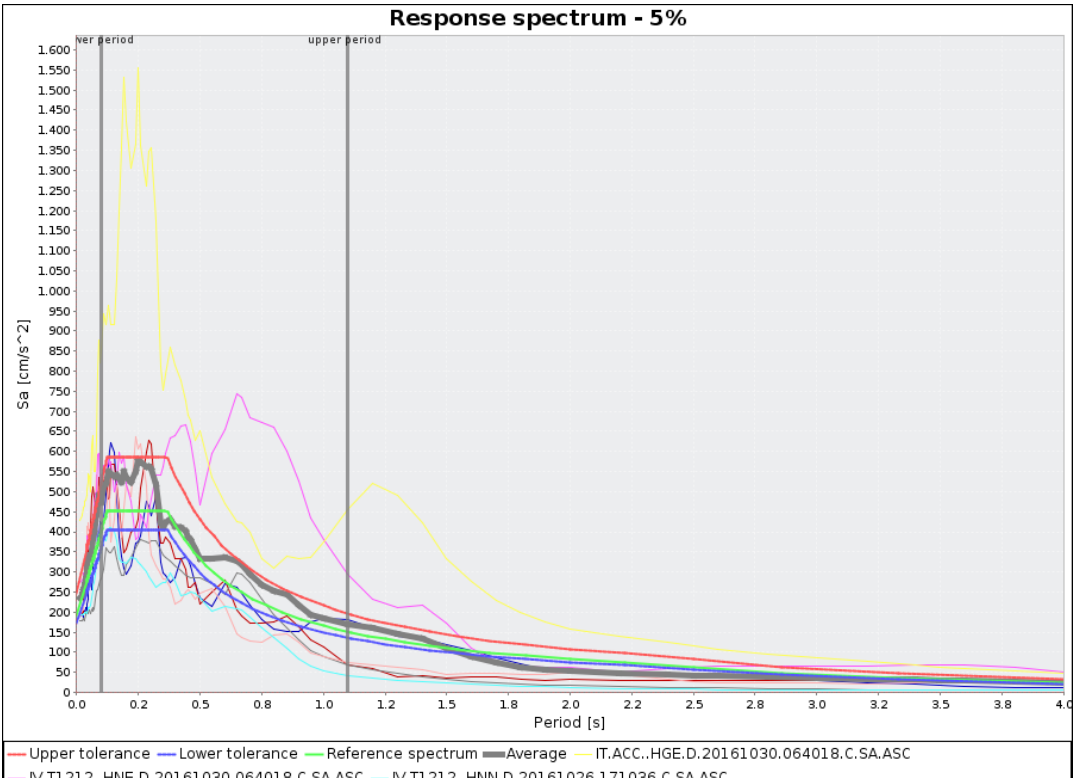
Figure 4. Horizontal reference spectrum (green line) within upper (30%, red line) and lower (10%, blue line) tolerance limits, and not-scaled acceleration spectra, compatible with the reference response spectrum. The thick grey line is the average of the seven selected acceleration spectra.